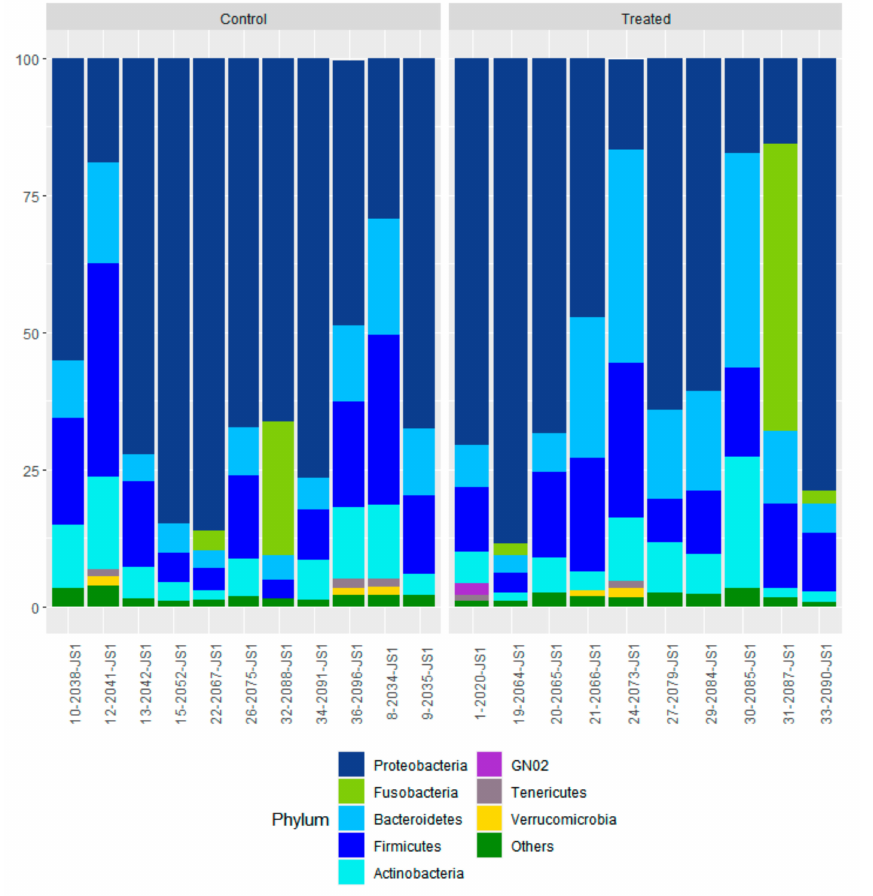
Figure 6. Nasal microbiota profiles of control calves at weaning. Data from 11 calves from control cows and cows supplemented with Se-yeast boluses (105 mg Se/wk), during the first (TR-1) trimester of gestation, that had WB-Se in the range of 0.06 to 0.13 ng/mL were compared with 10 calves from cows supplemented with Se yeast during the second (TR-2) and third (TR-3) trimesters of gestation that had WB-Se in the range of 0.15 to 0.21 ng/mL.